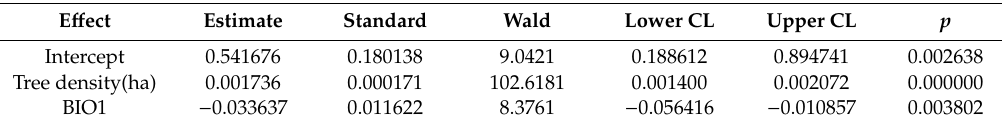
Table 4. Spearman rank order correlations between I UGZA and environmental variables. Only variables with a significant correlation are shown (* p < 0.05, ** p < 0.01). Variable R Tree density (ha.) 0.70 ** Number of trees 0.65 ** Number of species 0.54 ** Shannon index 0.45 ** Precipitation of May 0.43 * Precipitation of July 0.38 * BIO 18 (Precipitation of the warmest quarter) 0.35 * Temperature of August − 0.34 * BIO 1 (Annual mean temperature) − 0.35 * BIO 9 (Mean temperature of the driest quarter) − 0.38 * Table 5. Generalized Linear Model (GLM) results showing the most significant parameters correlated with the I UGZA